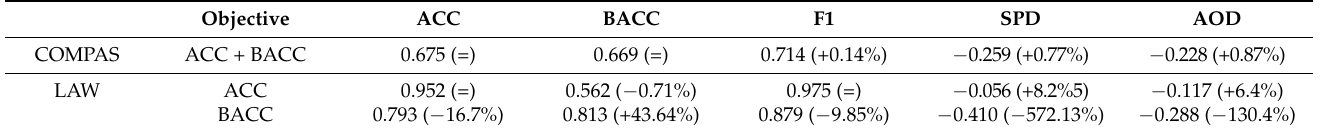
Table 5. LRC results for tuned hyperparameters. Performance was evaluated using stratified 10-fold CV. For SPD and AOD, values closer to zero indicate more fairness. The percentages in brackets display the differences compared to the baseline results, as presented by Table